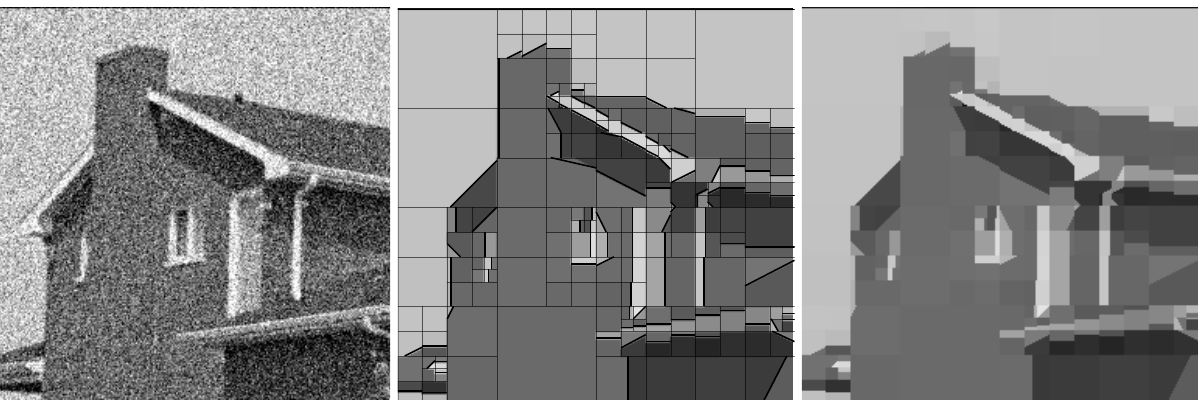
A noisy image ( left ) and ( right ) a fairly rough wedgelet representation for n = 256 ; the ( middle ) picture also shows the boundaries of the smoothness